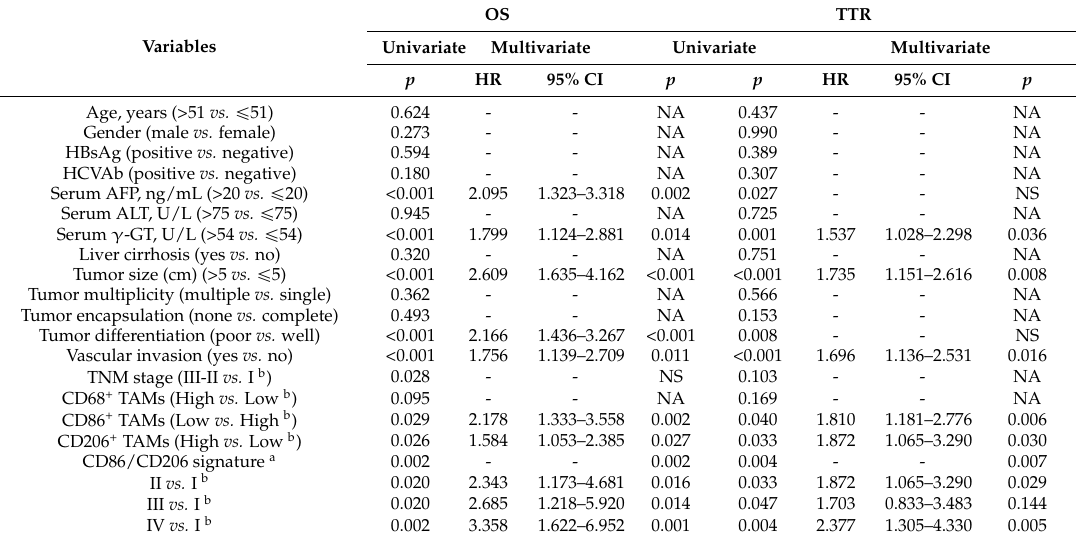
Table 2. Univariate and multivariate analysis of factors related to OS and TTR of HCC patients in the cohort ( n =